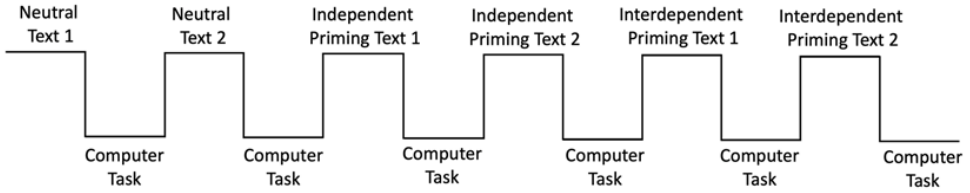
Figure 1. A schematic of the experiment procedure. The order of the independent and interdependent priming was counterbalanced between subjects.